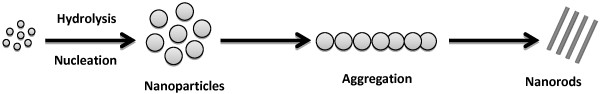
Possible growth mechanism of composite nanorods.